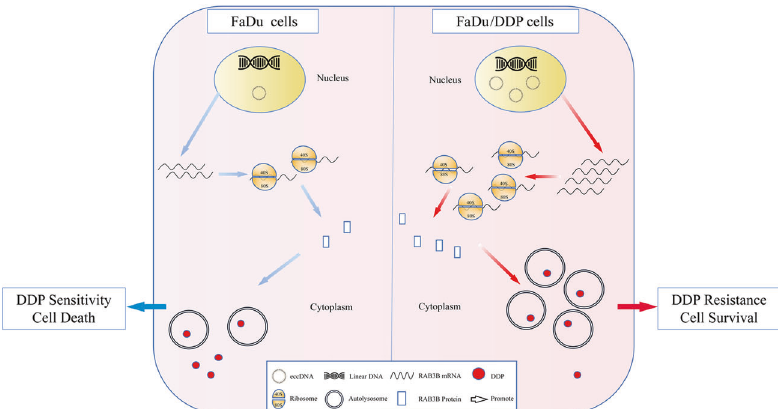
Fig. 6 Schematic representation for the role and mechanism of eccDNA in the DDP resistance of FaDu cells. eccDNA combined with linear DNA results in enhancement of DNA ampli fi cation, followed higher RNA transcription level, and then more protein translated. RAB3B, which totally or partly transcripted from eccDNA, promoted the DDP resistance of FaDu cells by inducing